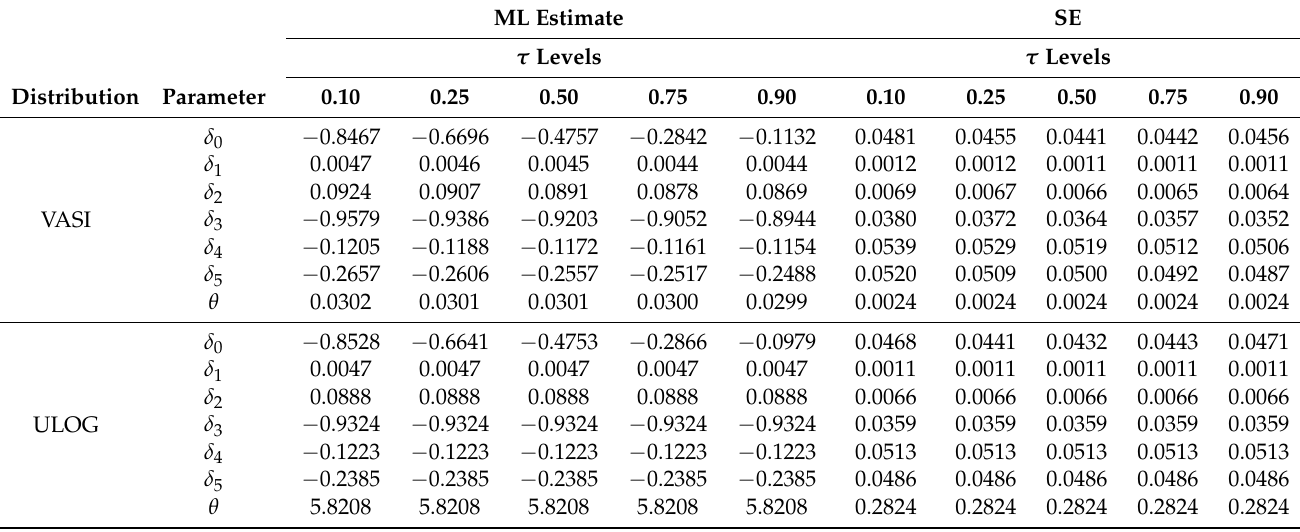
Table 7. ML estimates and SEs for the body fat proportion